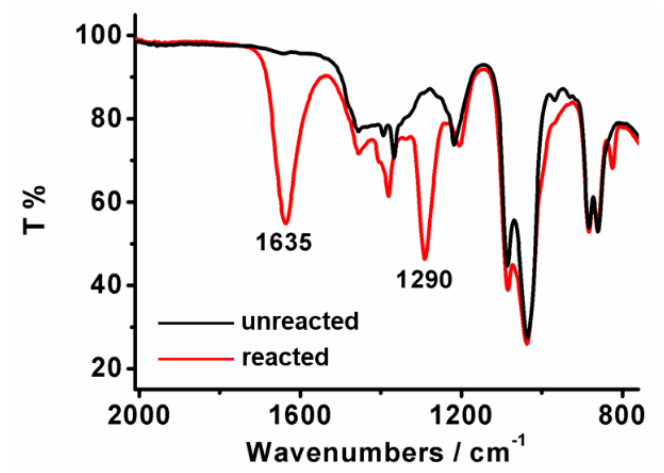
Figure 3. The FTIR spectra of TBAE-EG before and after CO 2 absorption.